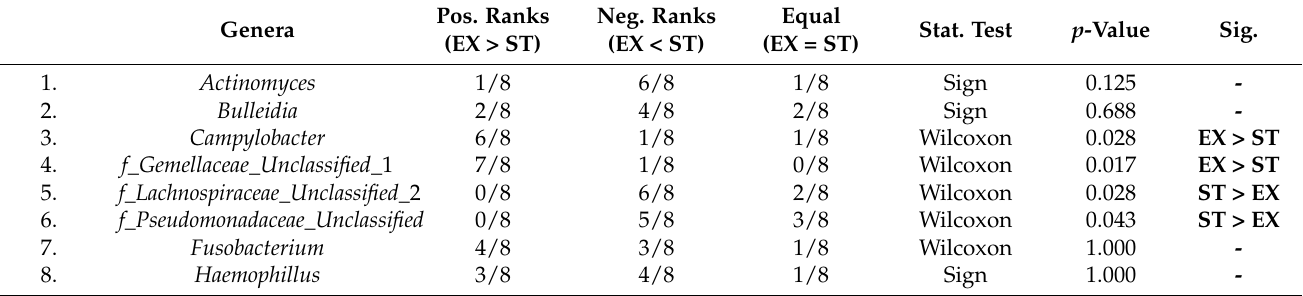
Table 3. The difference between the EX and ST states in terms of the relative abundance of genera detected in the study